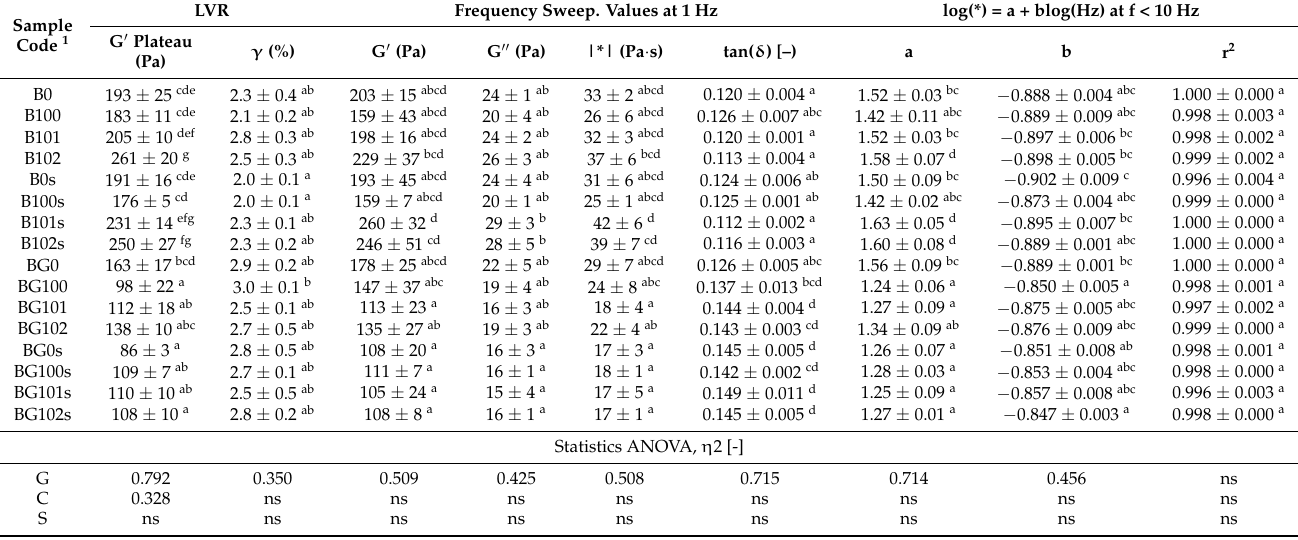
Table 5. Rheological parameters under oscillatory testing at 20 ◦ C (including: LVR values obtained in the amplitude sweep test at 1Hz; elastic (G (cid:48) ) and viscous (G (cid:48)(cid:48) ) moduli, complex viscosity *, and tan( δ ) values at 1 Hz obtained at the frequency sweep test at strain 1%; and parameters obtained by a power law (|*| = aHz b ) equation of the curve in a log–log plot) for the BBB before and after 21 days of